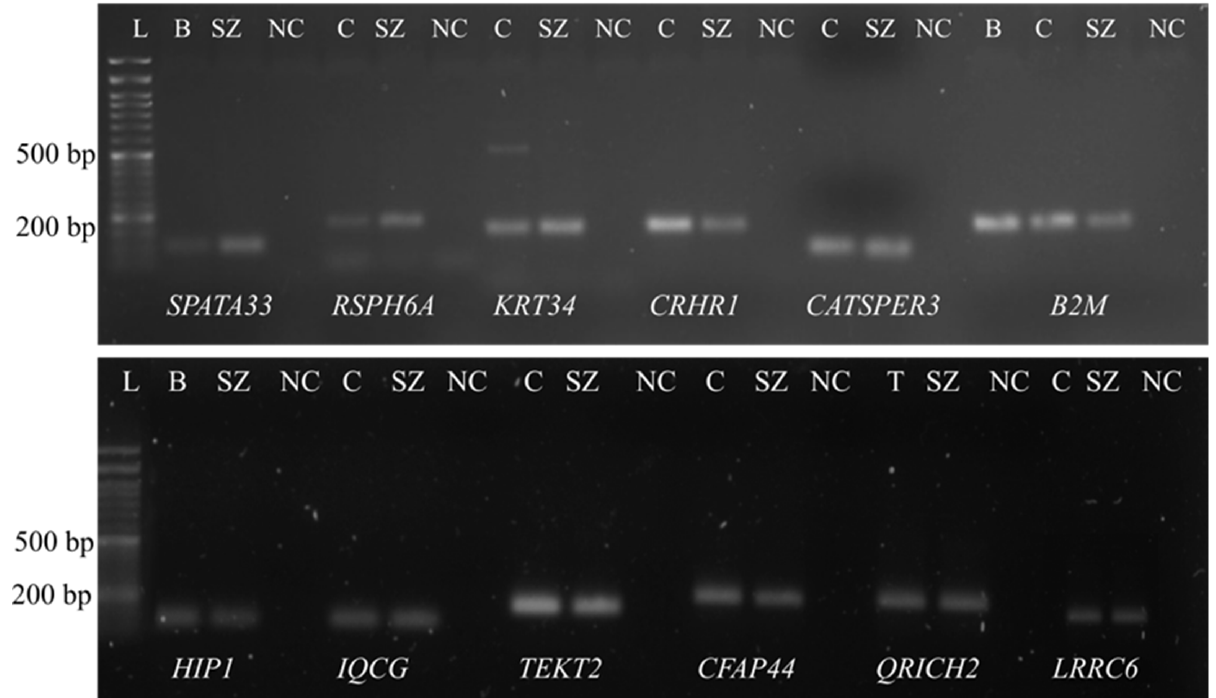
Figure 1. The presence of SPATA33 , RSPH6A , KRT34 , CRHR1 , CATSPER3 ( in the upper gel ), HIP1 , IQCG , LRCC6 , QRICH2 , TEKT2 and CFAP44 ( in the lower gel ) transcripts in human ejaculated sper- matozoa identified by PCR and running on a 1.5% agarose gel. B2M was used as control for the different tissues. L, DNA Ladder; B, blood; C, ciliated cells; T, testis; SZ, purified spermatozoa; NC, negative control.